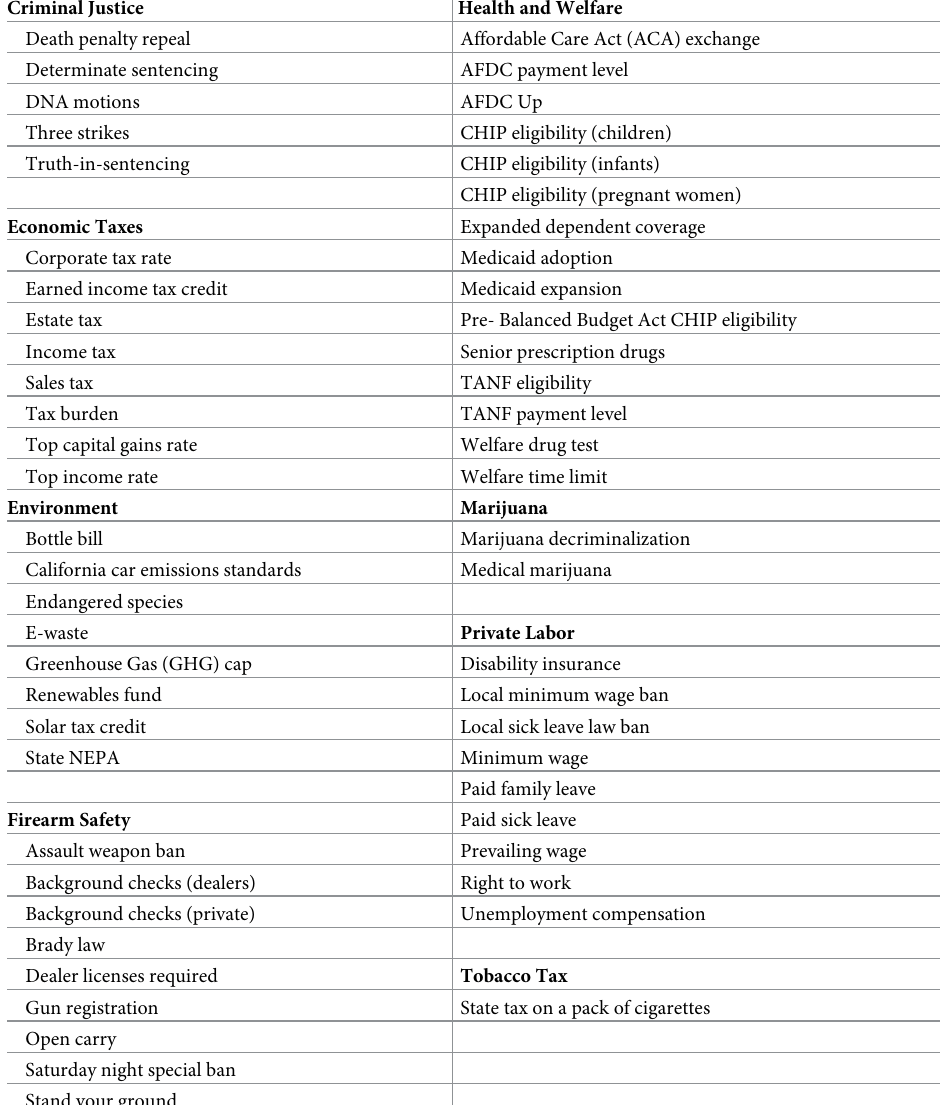
Table 1. Policies included in the eight domains (adapted from Grumbach